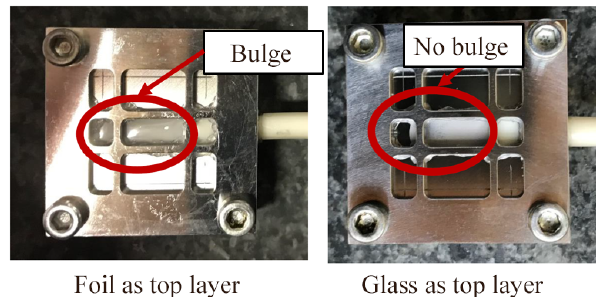
Figure 4. Bulging of the film as the top layer for injected